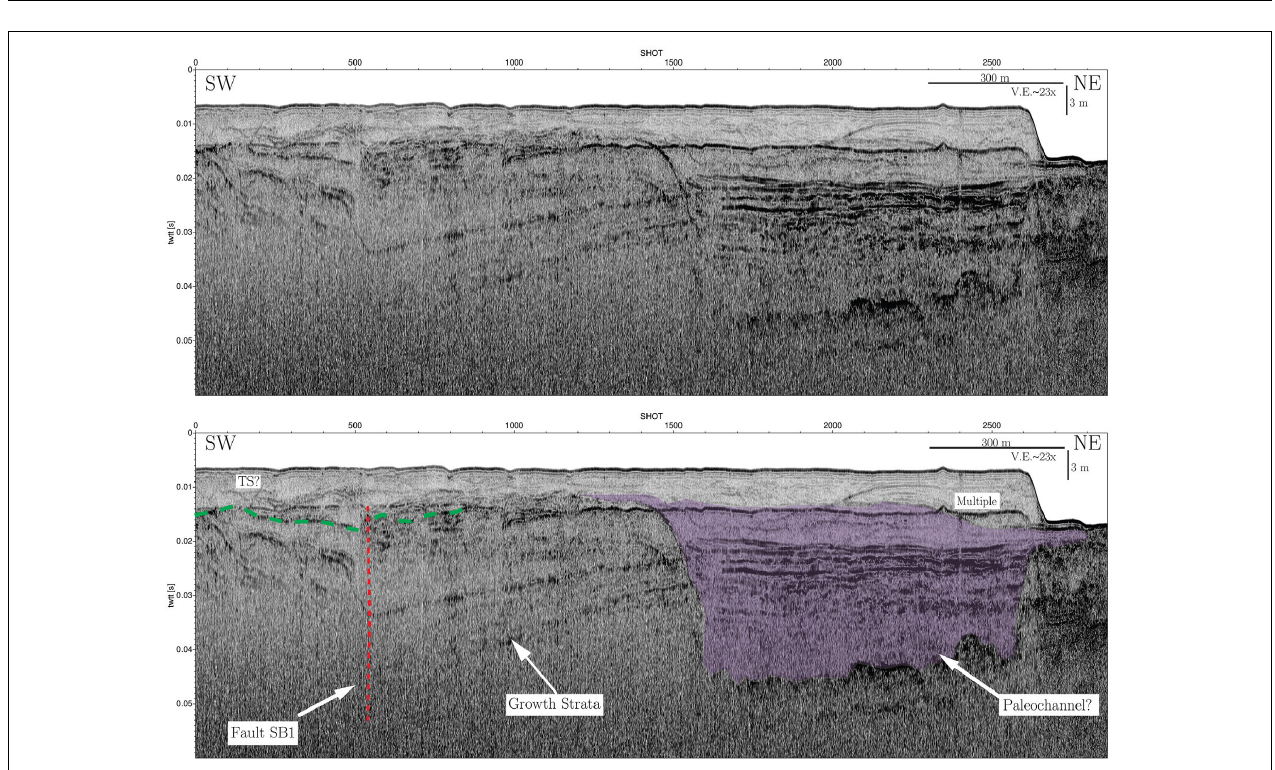
FIGURE 8 | Fence diagram of southernmost Chirp lines that image Fault SB1. Vertical white dashed line is trace of SB1. Green dashed horizon is the interpreted subaerially exposed surface from the Last Glacial Maximum sea level low-stand. Inset shows look direction and location of Chirp profiles.